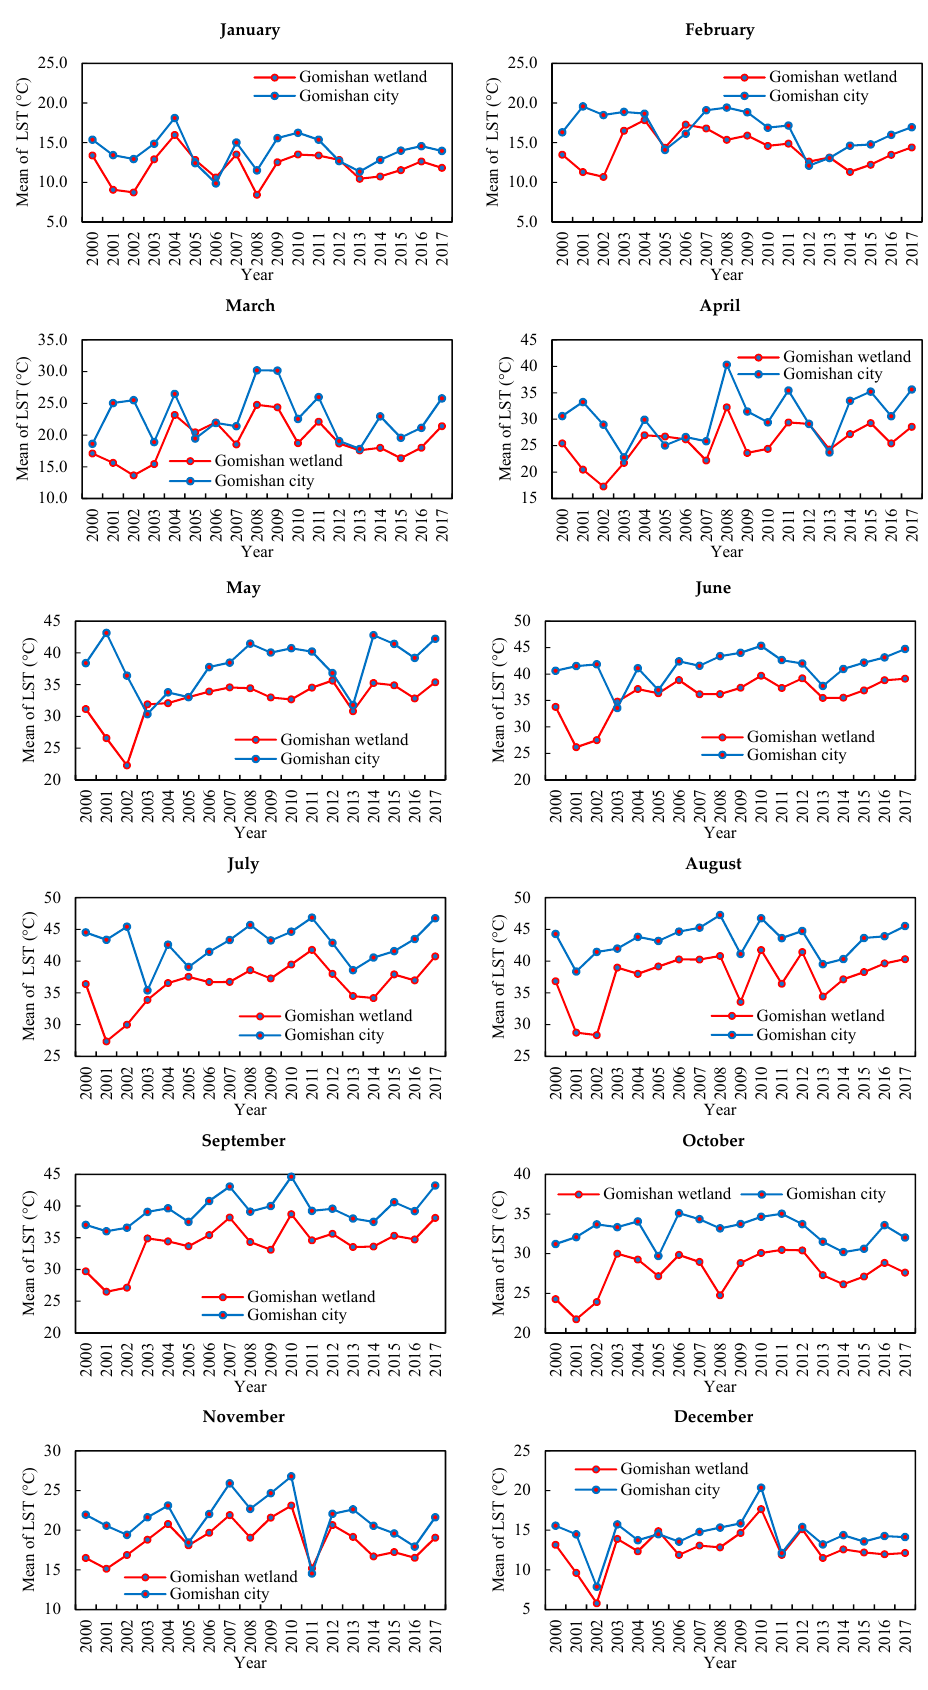
Figure 5. The LST mean for Gomishan city and wetland by different months in the period of 2000–2017.